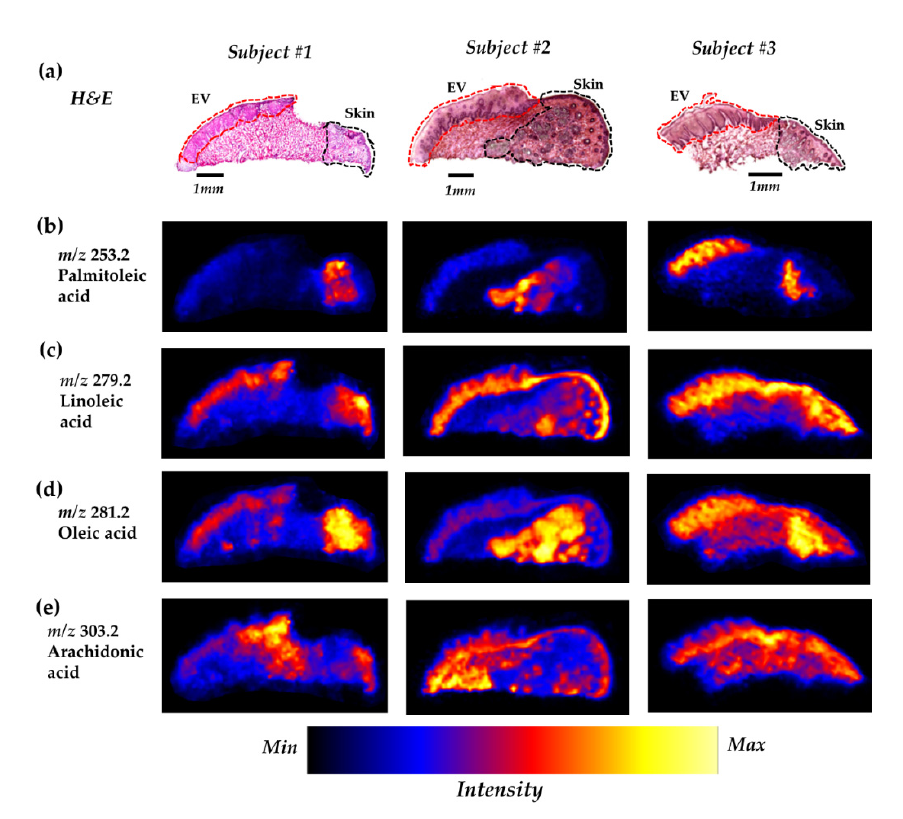
Figure 3. Prominent distributions of some free fatty acids across the vermilion and skin of the human lip. ( a ) Hematoxylin and eosin (H&E) images of lip section. Representative DESI–MSI ion images for ( b ) POA, ( c ) LA, ( d ) OA, and ( e ) AA. The area below the EV (not indicated in the H&E images) is